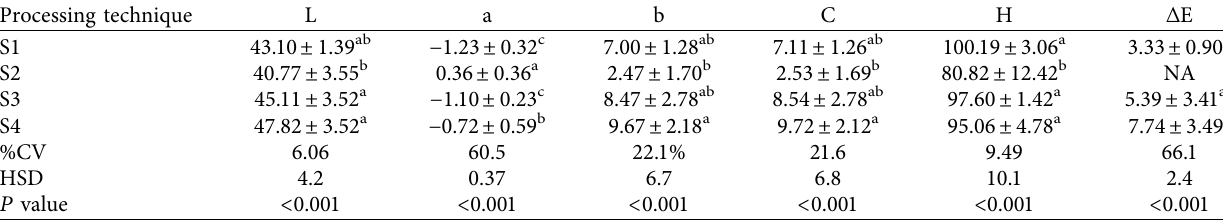
Table 4: Colour changes of traditional preserved cowpea